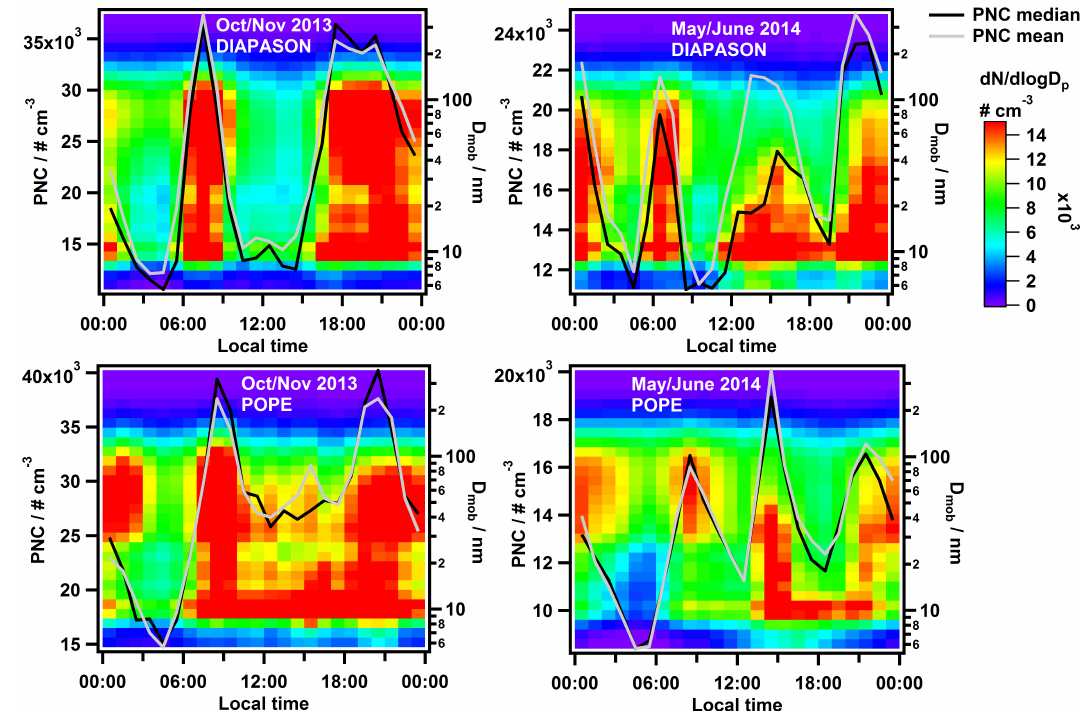
Figure 5. Average diurnal cycles of particle number concentrations and size distributions for DIAPASON (top) and POPE (bottom) for each year (left: 2013, right: 2014). Image plots of diurnal cycles of the particle number size distributions (colour coded for d N /dlog D p ) are shown with the particle diameters on the right axes (mobility particle diameter D mob ) . Mean (grey) and median (black) diurnal cycles of the total particle number concentrations are shown on the left axes. New particle formation at midday was only observed in the May/June 2014